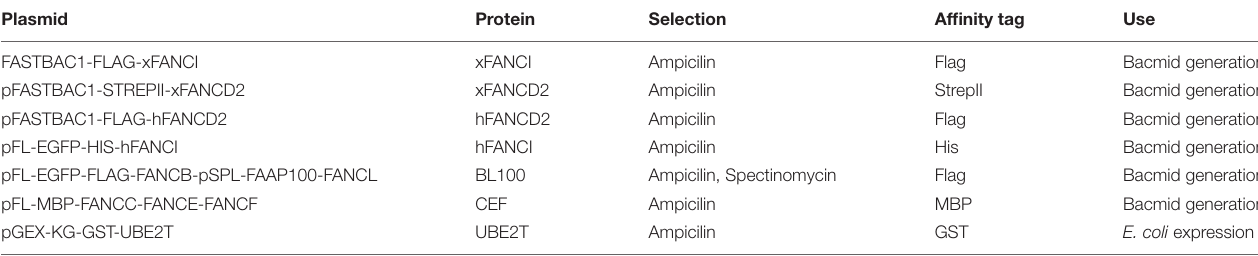
TABLE 1 | Plasmids and Bacmids used in this study. Plasmid Protein